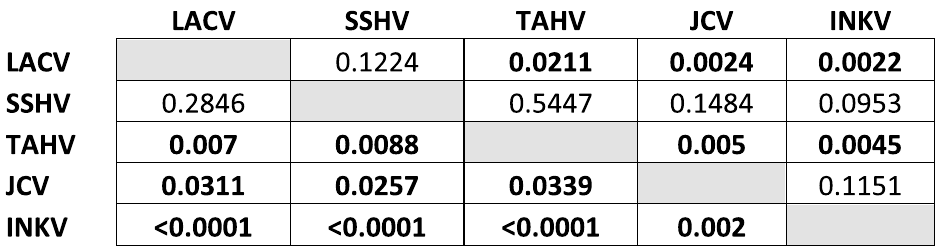
Table 2. P values comparing ND50s of homologous vs. heterologous viruses. P value was determined by One- way ANOVA with a Dunnett’s multiple comparison post-test in Prism. Bold = significant. Shaded cells indicates homologous